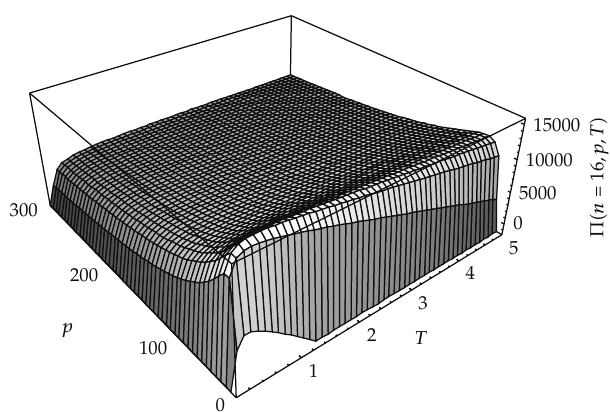
Figure 2: Concavity of the total profit function Π (cid:3) n (cid:4) (cid:3) n,p,T (cid:4) for fixed n (cid:8)